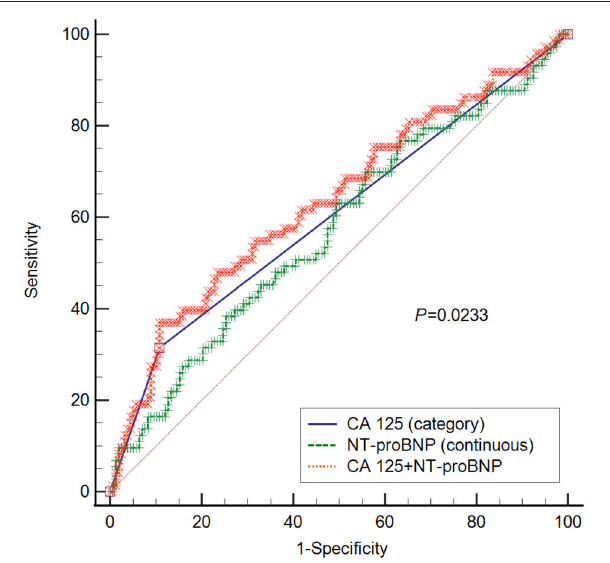
FIGURE 3 | ROC curve for CA 125, NT-proBNP, and CA 125 + NT-proBNP in predicting clinical worsening. P -value refers to the comparison between NT-proBNP and NT-proBNP + CA 125. No statistical significances were observed between CA 125 and NT-proBNP ( P = 0.5108), or CA 125 and CA 125 + NT-proBNP ( P = 0.2710). CA 125 is classified into two groups, namely CA 125 ≤ 35 U/ml and CA 125 > 35 U/ml; CA 125, Carbohydrate antigen 125; NT-proBNP, N-terminal pro-brain natriuretic